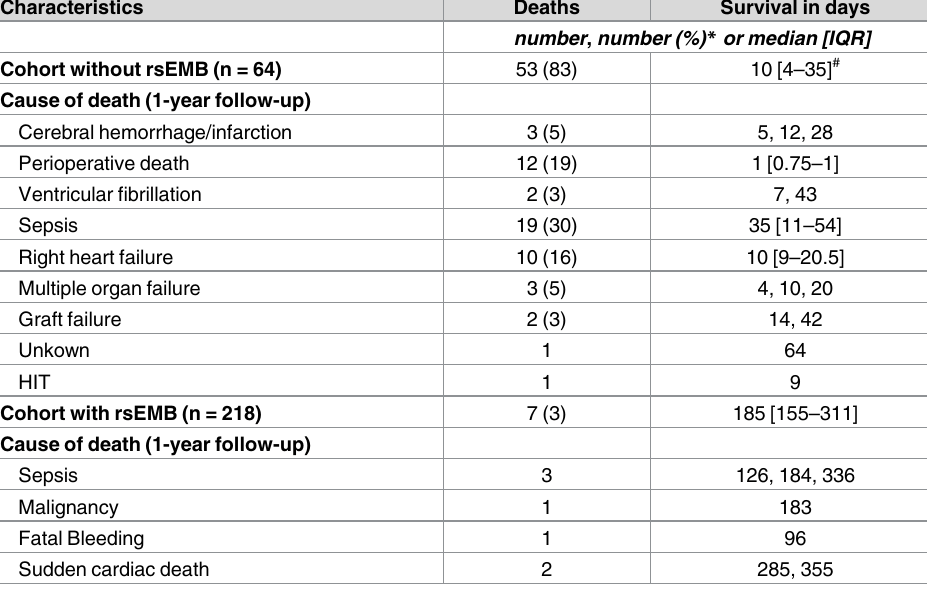
Table 4. Causes of death in the two